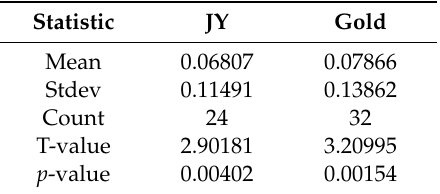
Table 4. h c − h T (HRs based on Indian Rps).